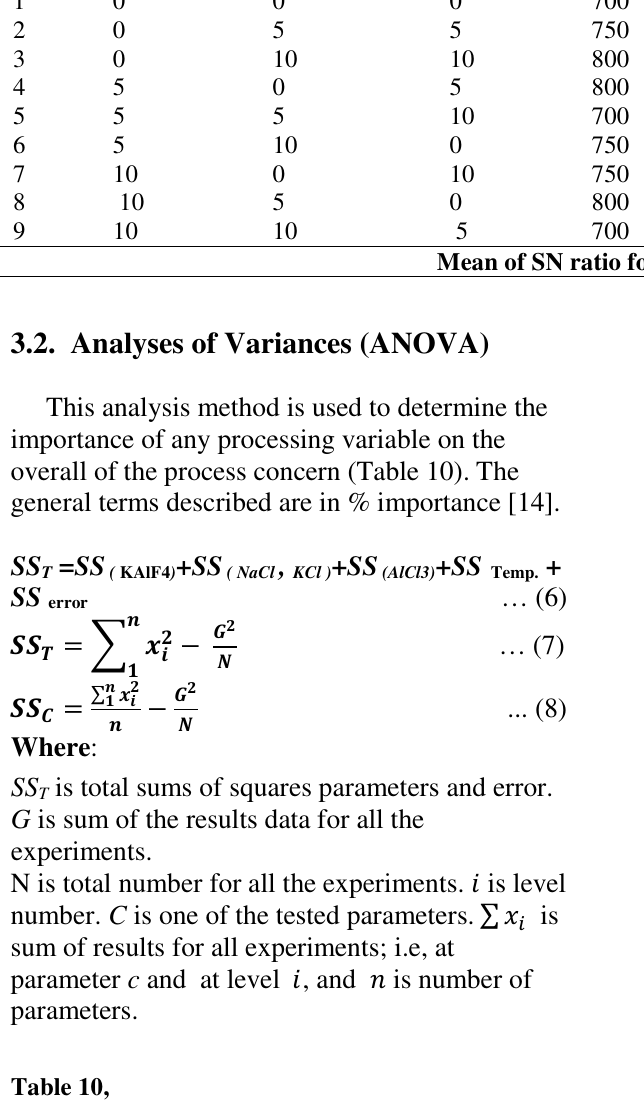
ANOVA for melting aluminum from slag for each controlled